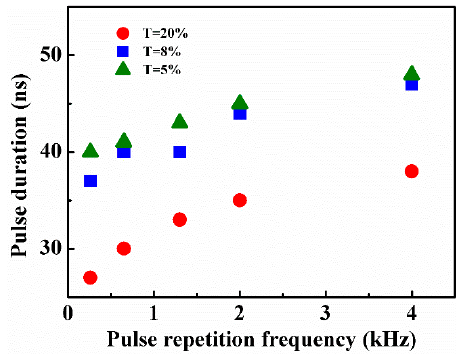
Figure 3. Pulse duration vs. pulse repetition frequency with different output couplers.